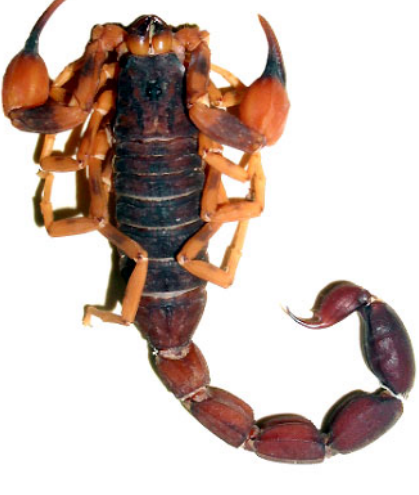
Figure 1. Male specimen of Tityus bahiensis Perty (CELT-1069) collected alive in Margarita Island, northeastern Venezuela. Scale =